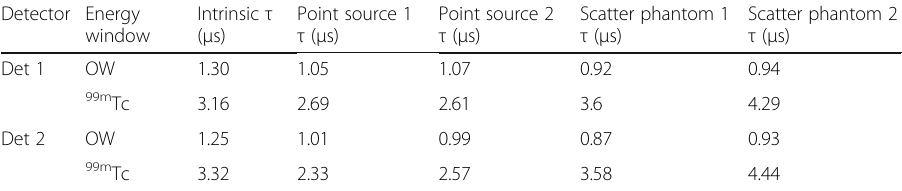
Table 4 Dead time values τ EW ( μ s) determined using the graphical method Detector Energy window